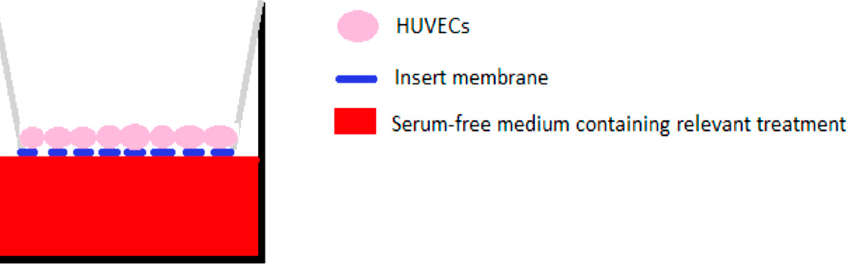
Figure 3. Schematic of a Transwell ® migration assay. Human Umbilical Vein Endothelial Cells (HUVECs) were seeded on the top of the semi-permeable membrane with treatments, star-poly(glutamic acid) (PGA) – Stromal-Derived Factor 1 α (SDF)–HA–TA supernatant or HA–TA alone supernatant, placed in the bottom of the well, underneath the membrane. In the presence of a migratory stimulus HUVECs will travel through the membrane.